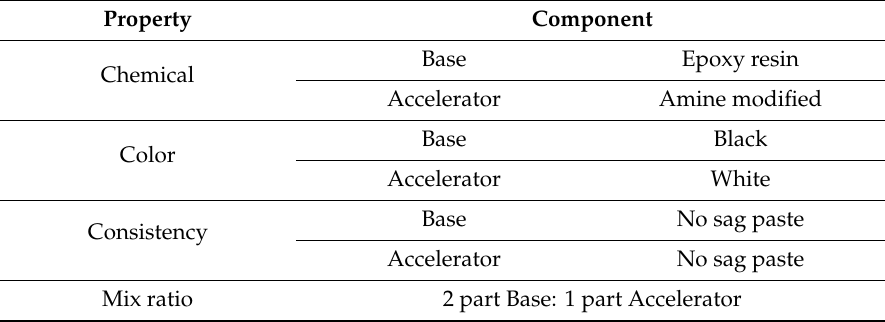
Table 3. Adhesive data.